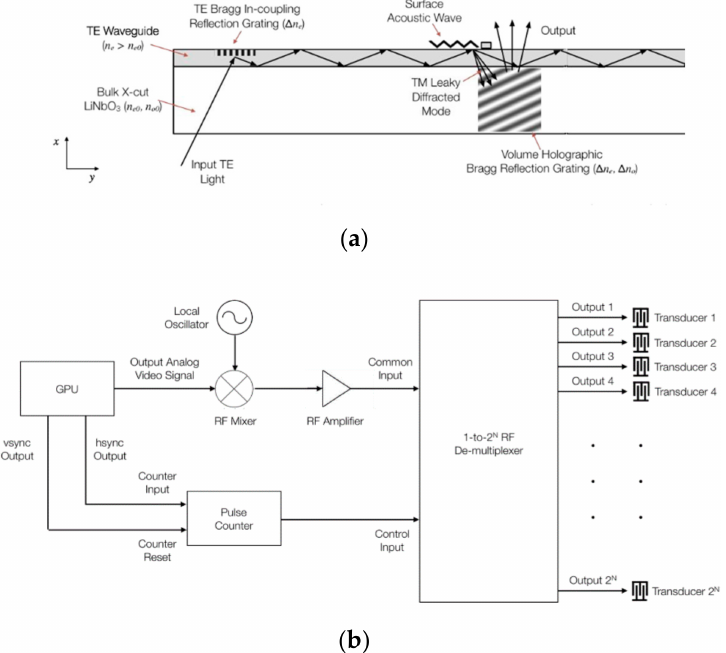
Figure 16. ( a ) One cell of a cascaded IDT configuration for front-emitting leaky mode devices, in which guided-mode light that remains undiffracted after interaction with a surface acoustic wave remains available for interaction with and diffraction via surface acoustic waves generated by additional IDTs placed on the same waveguide. ( b ) RF driving scheme for a multi-channel, multi-hogel instantiation of a leaky mode device, in which RF outputs per channel and hogel are sequentially triggered via the GPU clock signals. Reprinted with permission from [48]. Single-chip, near-eye devices have been demonstrated for small numbers of points by McLaughlin et al. [18]. His device employed a pulsed illumination source to obviate the need for descan optics. In this work, he was able to refocus a virtual line from 4 to 10 feet by varying the chirp rate of the surface acoustic wave pattern (Figure